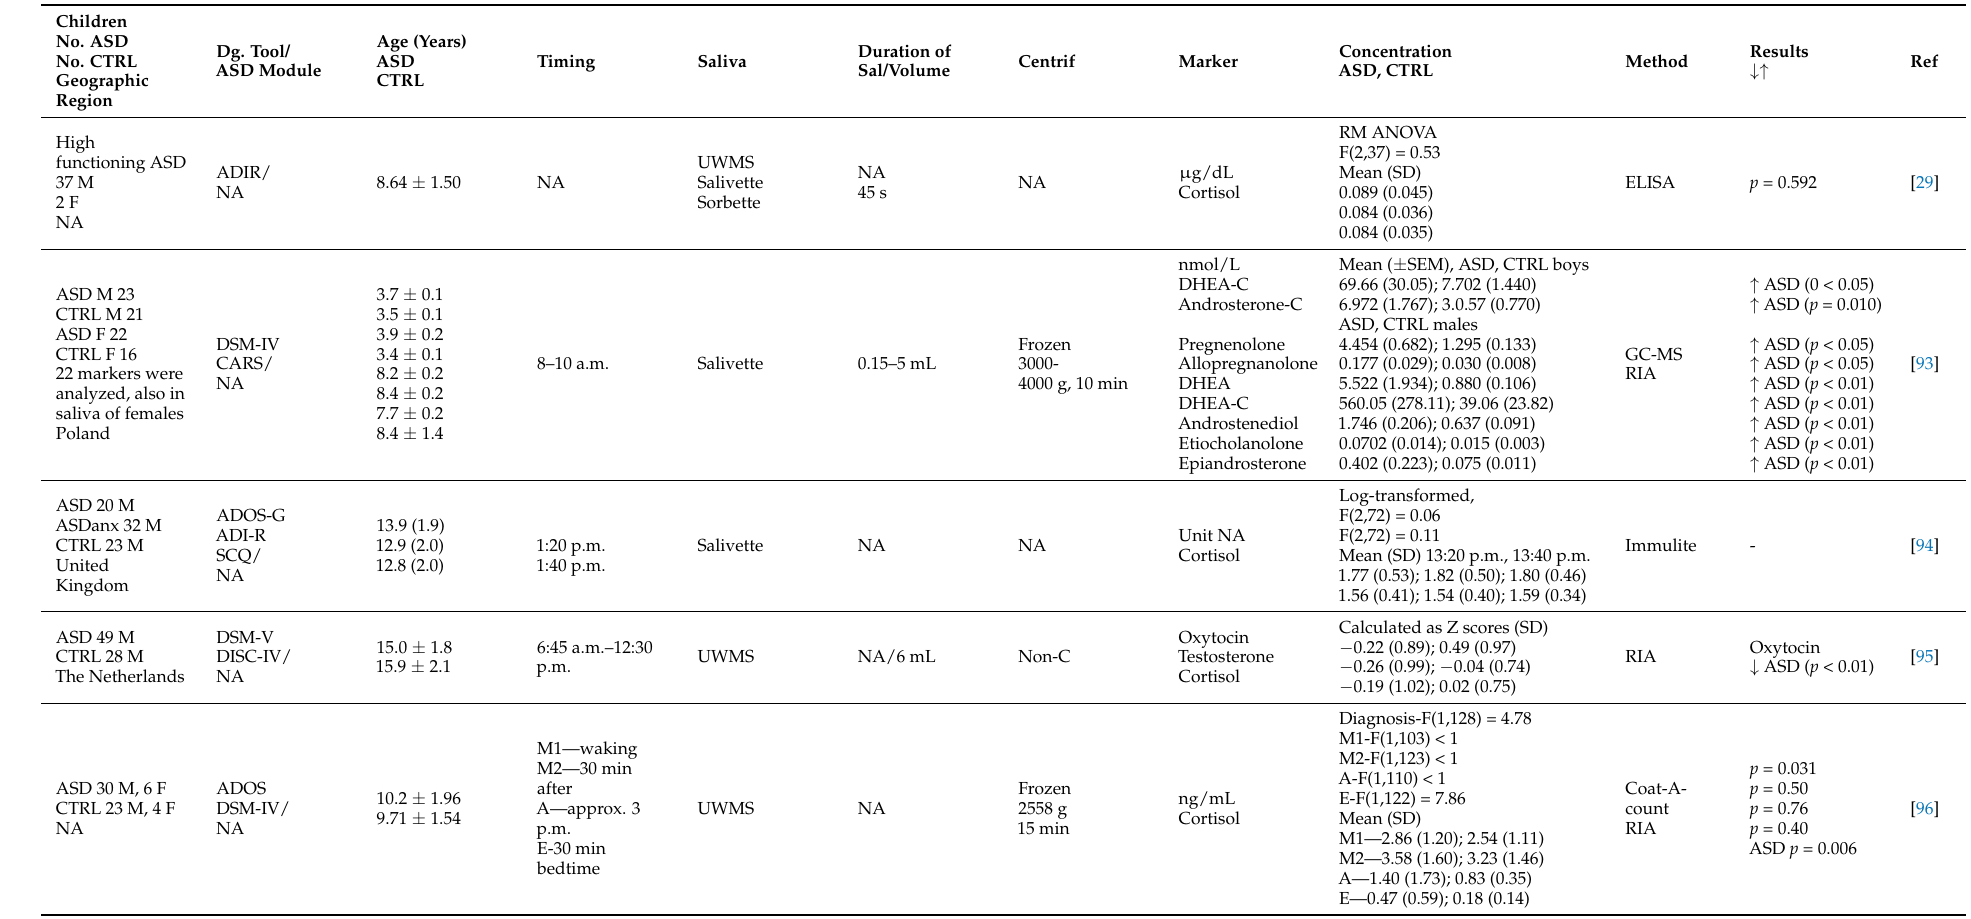
Table 2. Hormones in saliva of autistic